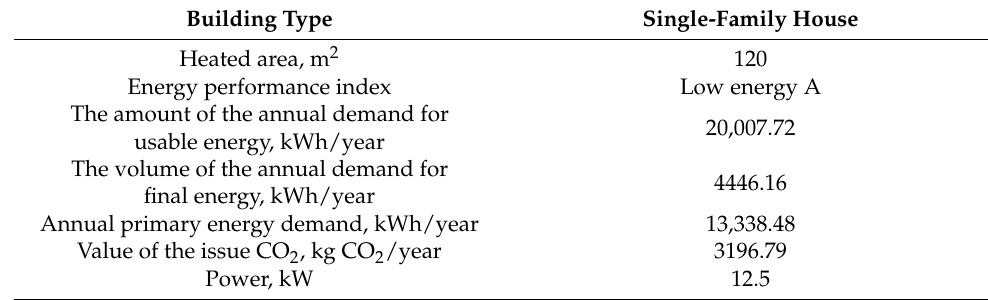
Table 11. Energy parameters of the building after using the brine-water heat pump. Building Type Single-Family